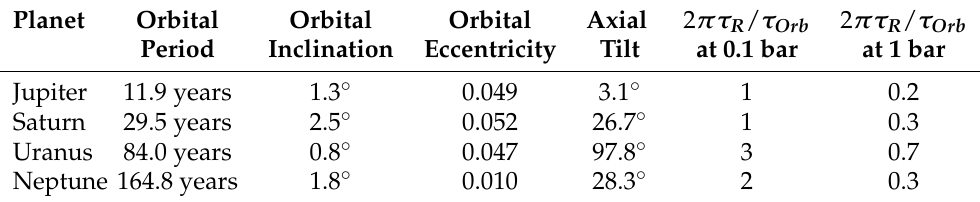
Table 3. Planetary Orbital Parameters and Radiative Time Constants